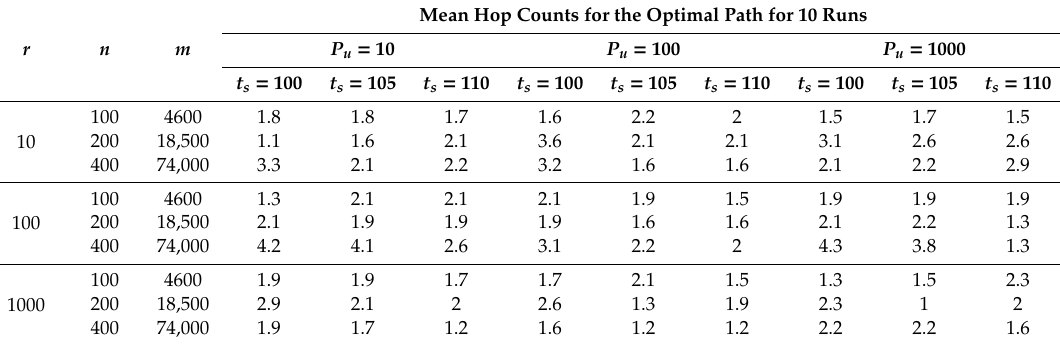
Table 12. Mean hop counts for the e ff ective path for the SESE algorithm for 10 Mb